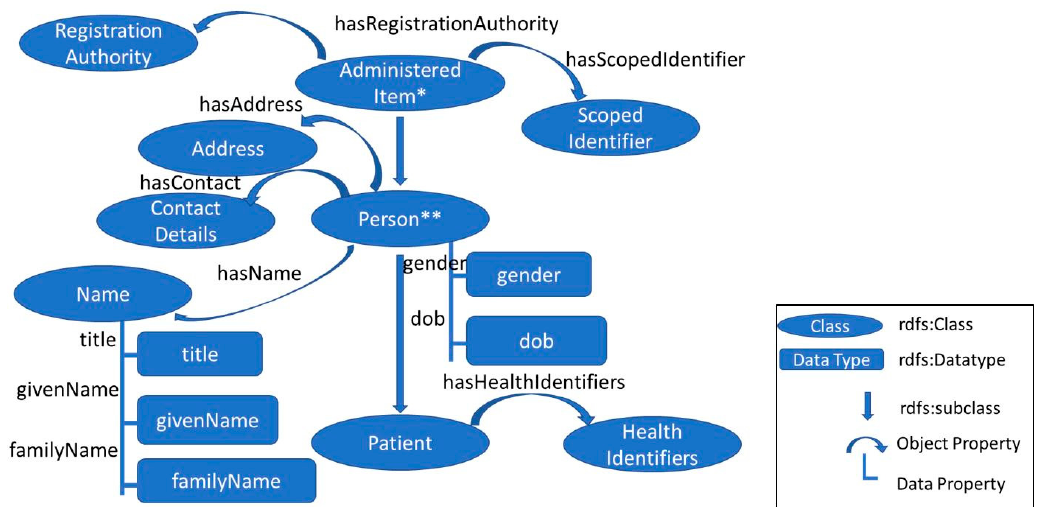
Figure 1. Conceptual model for demographic detail, aligned with metarep * and FHIR **, see Table 2.